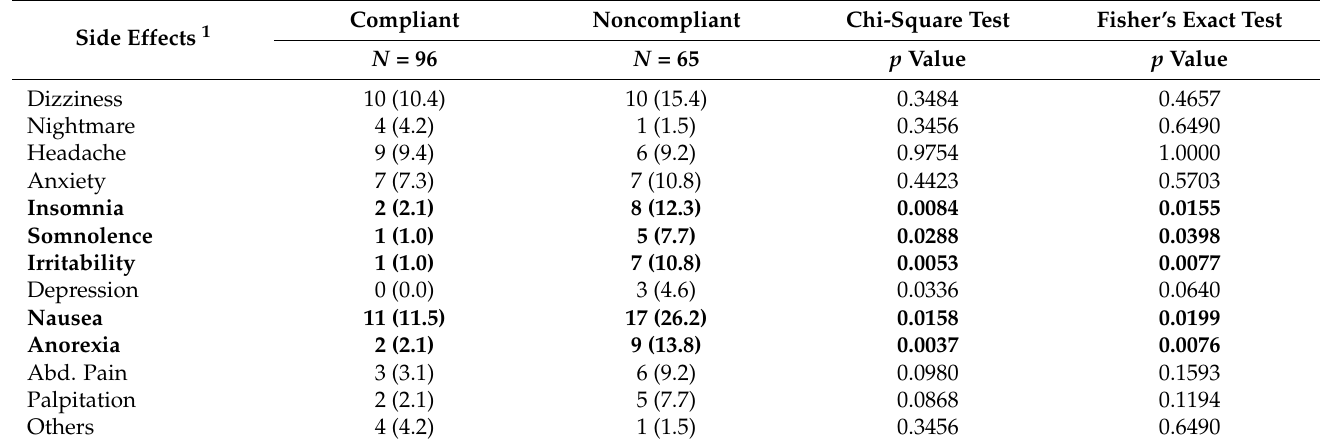
Table 3. Associations between side effects and drug compliance. N =